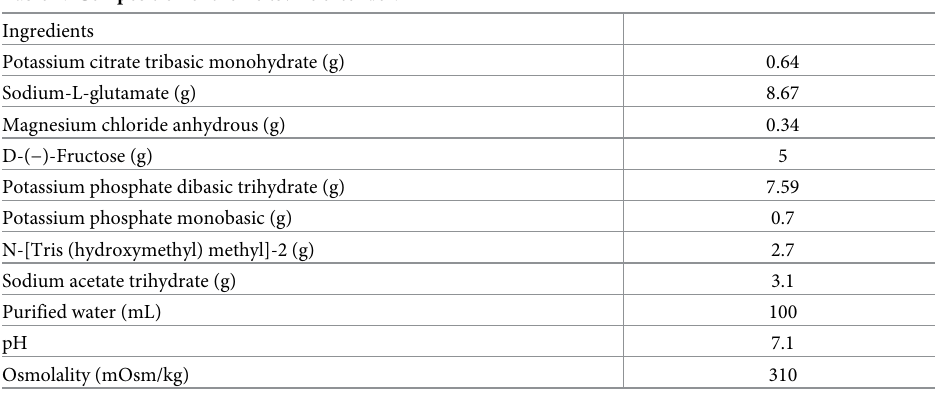
Table 1. Composition of the Beltsville